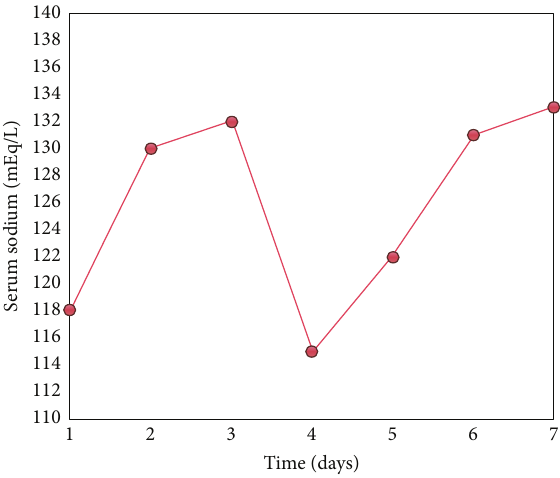
Figure 3: Changes in serum sodium levels during hospital stay.